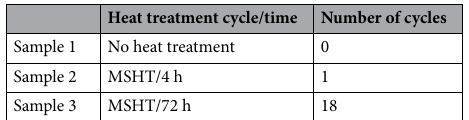
Table 2. Heat treatment of the three sintered-metal-fibers samples.